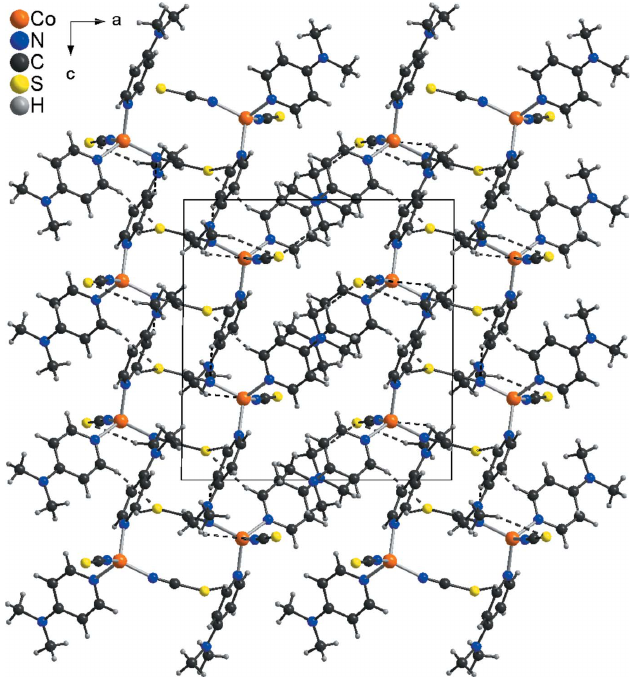
Figure 6 Crystal structure of form II with view in the direction of the crystallographic b -axis. Intermolecular C—H (cid:2)(cid:2)(cid:2) S and C—H (cid:2)(cid:2)(cid:2) N hydrogen bonds are shown as dashed lines.